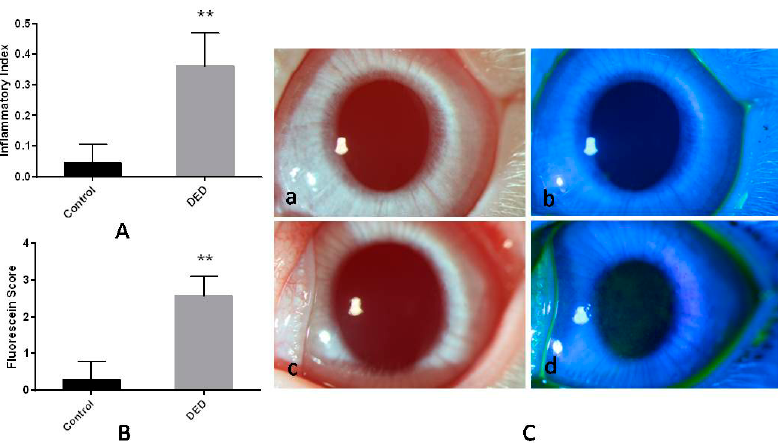
Figure 1. In vivo observations of ocular surface inflammation and corneal fluorescein staining in control and dry eye disease (DED) eyes. ( A ) The inflammatory index in the two groups. The DED group had a significantly higher inflammatory index than the control group; ( B ) the corneal fluorescein staining scores in the two groups. The DED group had a significantly higher fluorescein staining score than the control group; ( C ) photographs of corneas stained with and without fluorescein sodium. Signs of ocular abnormalities were not observed in the control eyes ( a , b ). Corneal edema and diffuse epithelial disruption were observed in the DED eyes ( c , d ) (16 × ). ** p < 0.01.